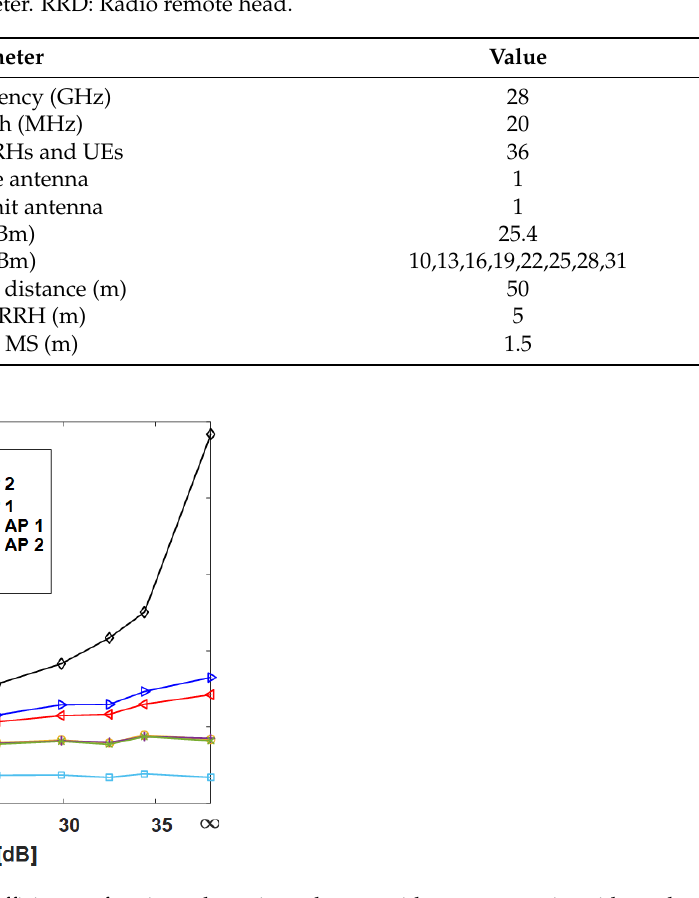
Figure 9. Average spectral efficiency of various clustering schemes with respect to γ in grid topology. AP: Affinity